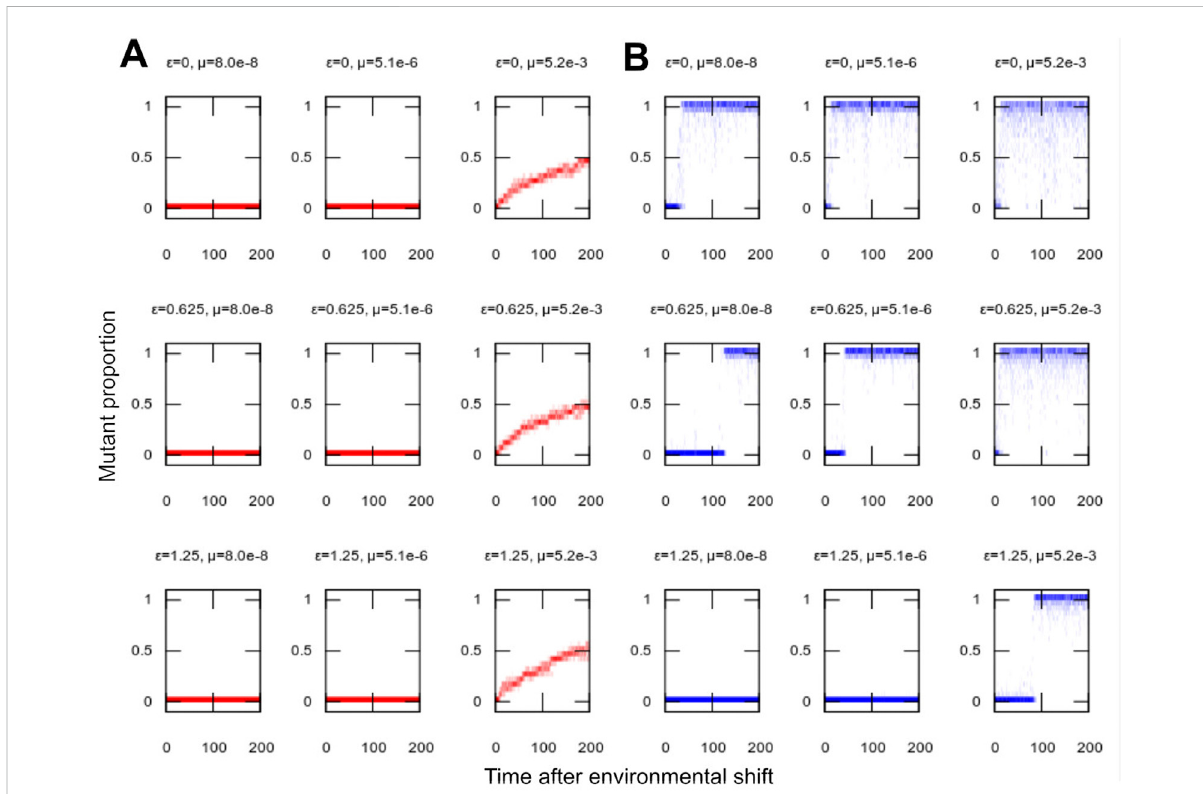
FIGURE 2 Population structure in adaptation to new environments. Population distribution of mutant proportion h with time in simulations adapting to a new environment (as in Figure 1). (A) No segregation σ = 0; (B) nonzero segregation σ = 0.2. Distributions of h are presented for single example simulationswiththegivenparameterisations.Lowermutationratesallowmorehomoplasmicpopulations(tighter h distributions),but,intheabsence of segregation, challenge adaptation to the new environment (slow or no progress towards h = 1). Higher mutation rates facilitate adaptation but lead to more heterogeneous populations (wider h distributions). Segregation allows both rapid adaptation and high levels of